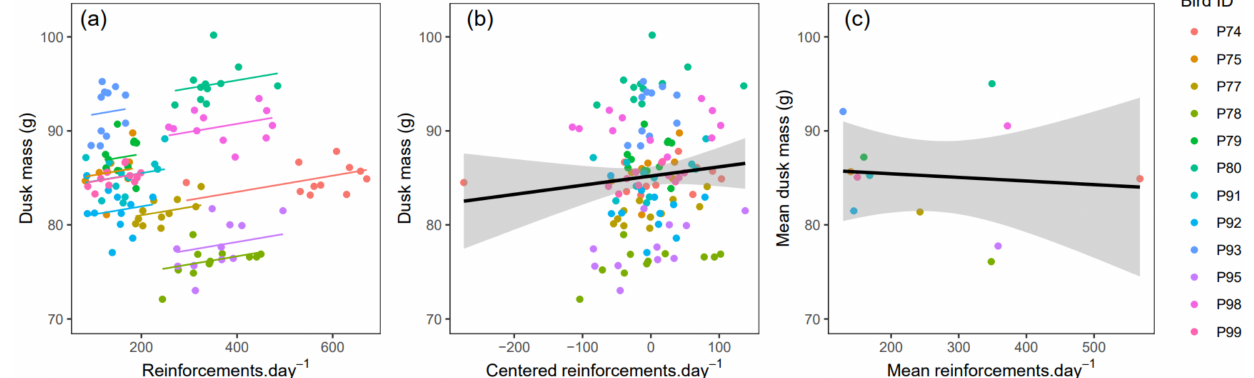
Figure 8. The positive effect of foraging effort (daily reinforcements earned) on dusk body mass is driven by a within-subjects effect. ( a ) Scatterplot of dusk mass by the total number of reinforcements ·× day − 1 with each point representing the data from one bird day. Lines show the fitted values from a standard mixed model that combines within- and between subject effects. ( b ) Scat- terplot of dusk mass by within-subject centred reinforcements ·× day − 1 with each point representing the data from one bird on one day. The line shows the significant positive within-subject effect. ( c ) Scatterplot of mean dusk mass by mean reinforcements × day − 1 with points representing birds. The line shows the absence of a positive between-subject